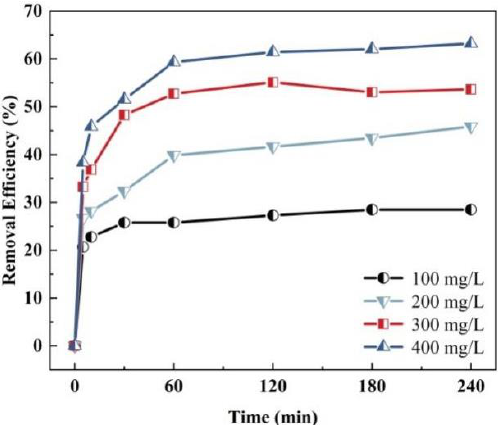
Figure 7. Effect of adsorbent dosage on HA adsorption by RGO-SiO 2 .